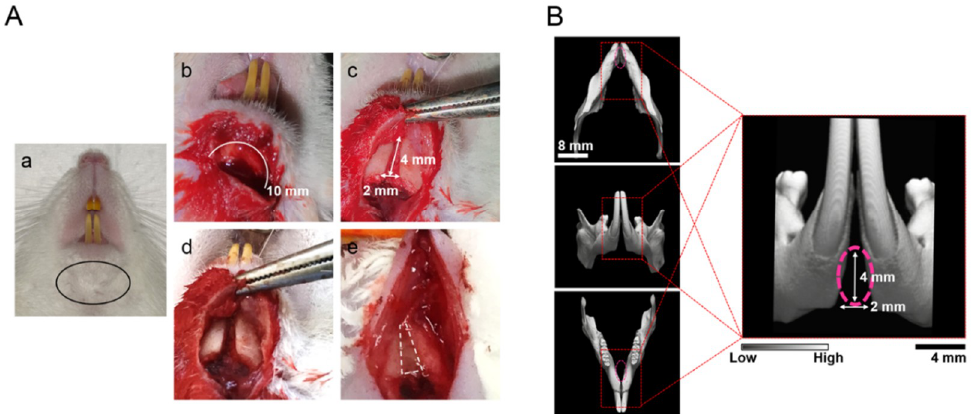
Figure 2. Rat congenital cleft-jaw model. ( A ) The surgical procedure to prepare the congenital cleft-jaw model in the mandibular symphysis. ( A-a ) Black eclipse: incision part. ( A-b ) White line: incision line to disclose the mandibular symphysis. ( A-c ) The fibrous tissue in the mandibular symphysis (4 × 2 mm was removed by the sharp curettes). ( A-d ) Prepared bone defect for the implantation. ( A-e ) Representative image of implanted vhEGCG-GS. ( B ) Pink broken circle: micro-computed tomography (μCT) image of the congenital bone defect in the mandible symphysis.